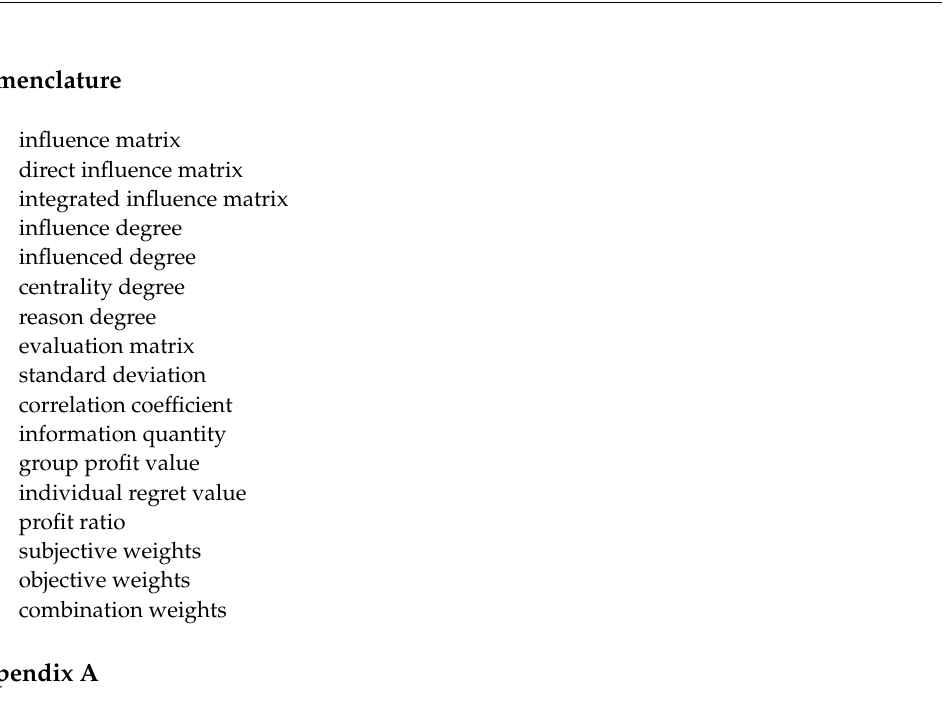
Table A1. Initial direct influence